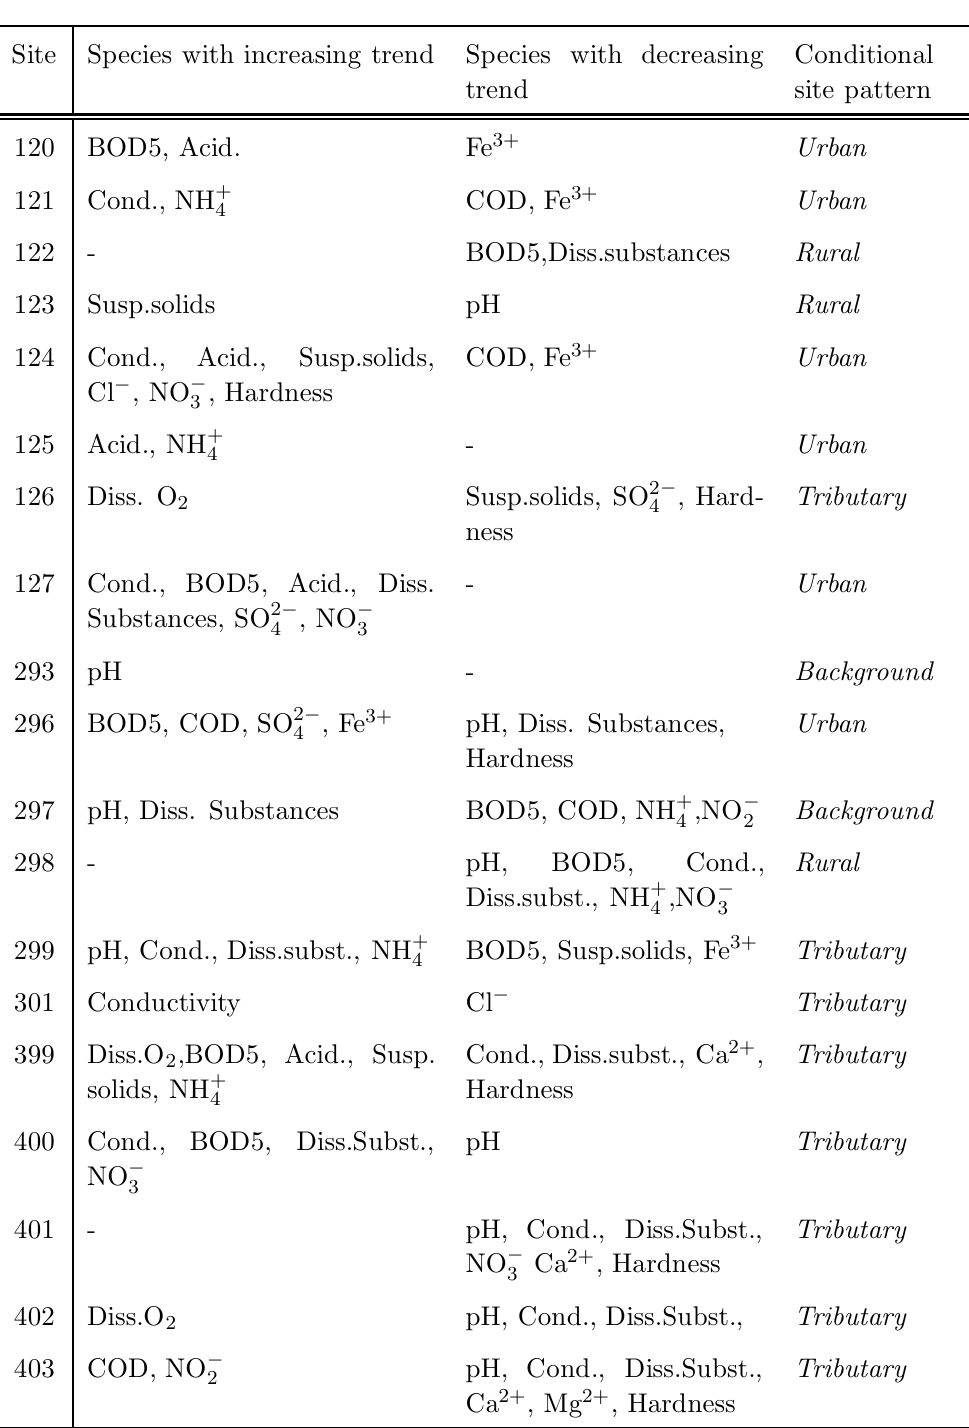
Table 2 Summarized Trend Distribution for all